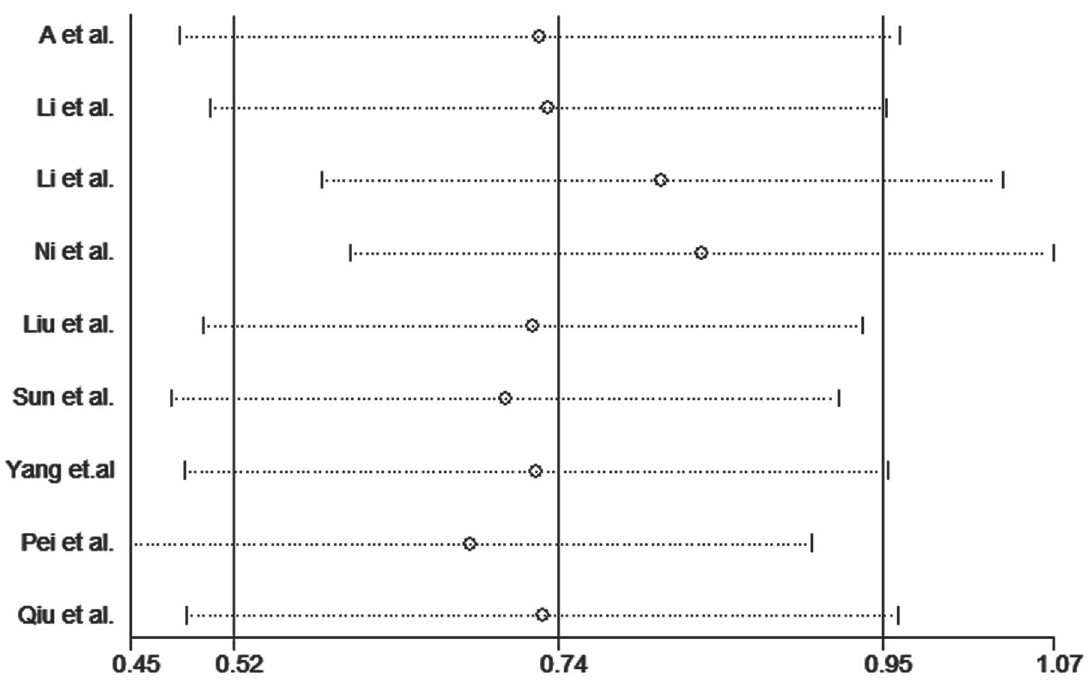
Fig 9. Sensitivity analysis diagram for each study used to assessthe relative risk estimates for the MTHFR C677T polymorphism and male infertility in all of the included studies. (additive model: TT vs. CC).